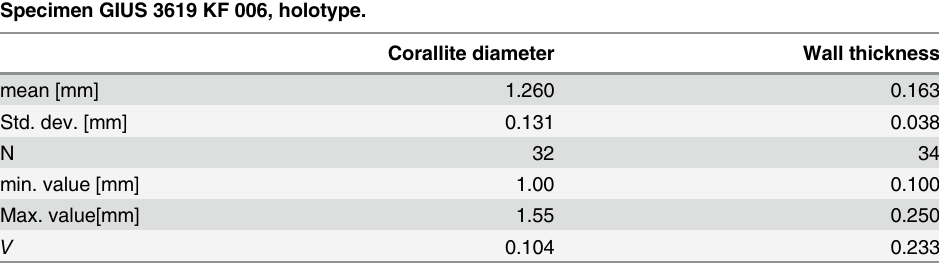
Table 4. Intracolonial variation in Syringopora hilarowiczi sp. nov. Specimen GIUS 3619 KF 006,